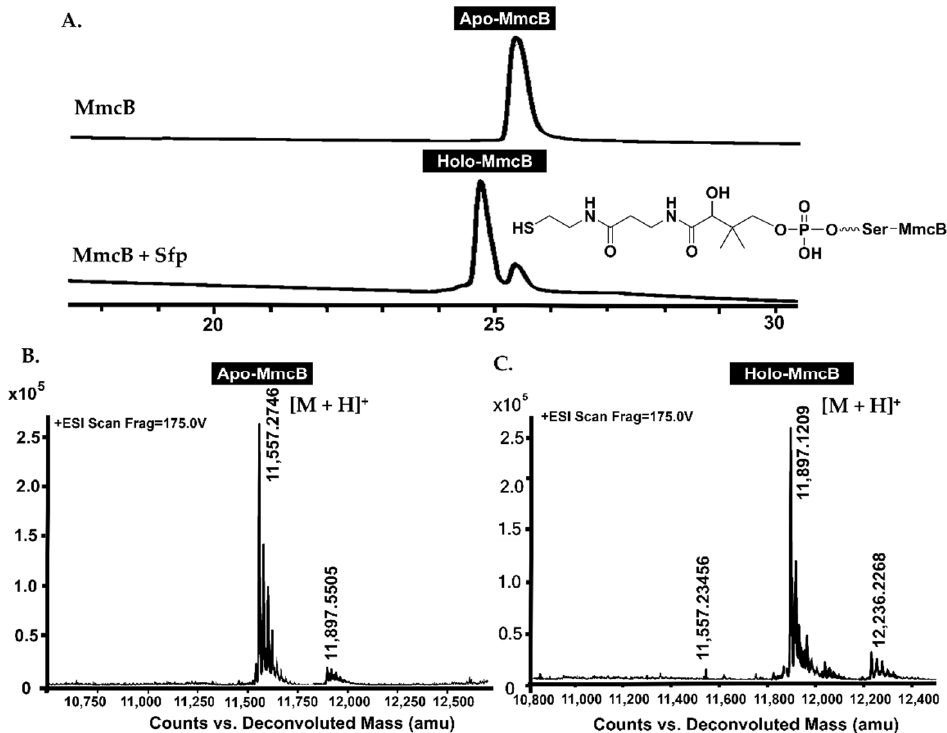
Figure 4. The LC-MS analysis results of the apo - and holo -form of MmcB. ( A ) The retention time of the apo - and holo -form of MmcB by HPLC analysis. ( B ) The molecular weight of the apo -form MmcB. ( C ) The molecular weight of the holo -form MmcB.